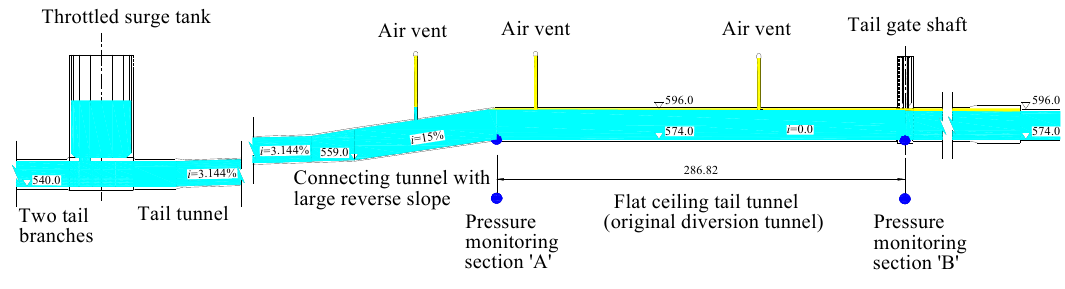
Figure 5. Layout of the tail system.